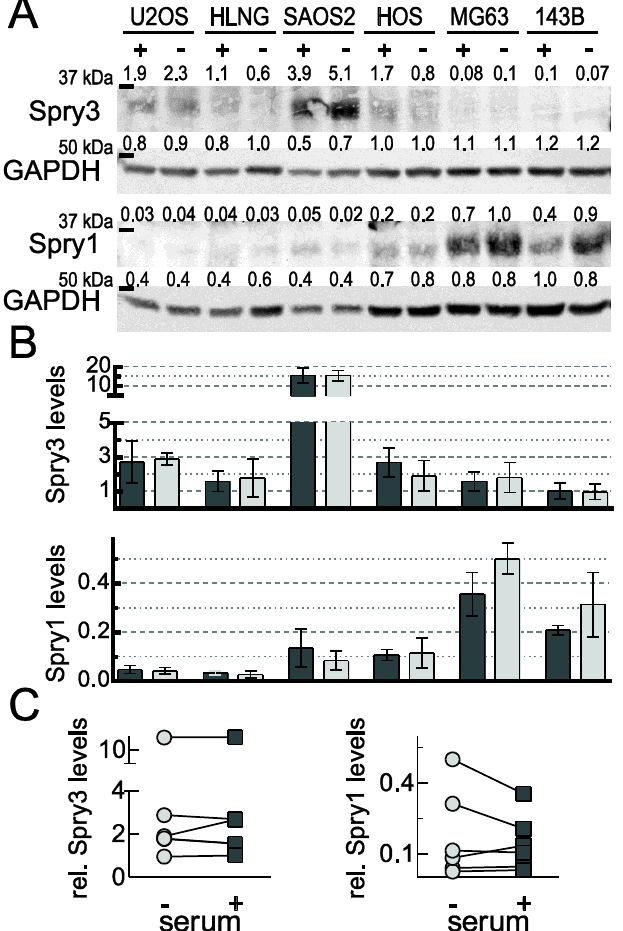
Figure 2. Endogenous Spry3 and Spry1 protein levels in osteosarcoma-derived cell lines. ( A ) The indicated osteosarcoma-derived cell lines were cultured for 24 h in the absence (−) or presence (+) of serum. Using immunoblotting, endogenous Spry3 and Spry1 protein amounts were detected. Loading was determined by using antibodies recognizing GAPDH. The mean values were arbitrarily set as 1. ( B ) Quantification results of three independent performed Western blot experiments are depicted as mean ± SEM in a column graph. Expression levels of Spry3 and Spry1 proteins were calculated as the ratio to the mean values of the experiment (in case of Spry3 the numbers for SAOS2 were not included) by Image Quant software and normalized to GAPDH. ( C ) Quantified Spry3 and Spry1 levels from cells grown in serum-deprived (circle) and –supplemented (square) mediums are